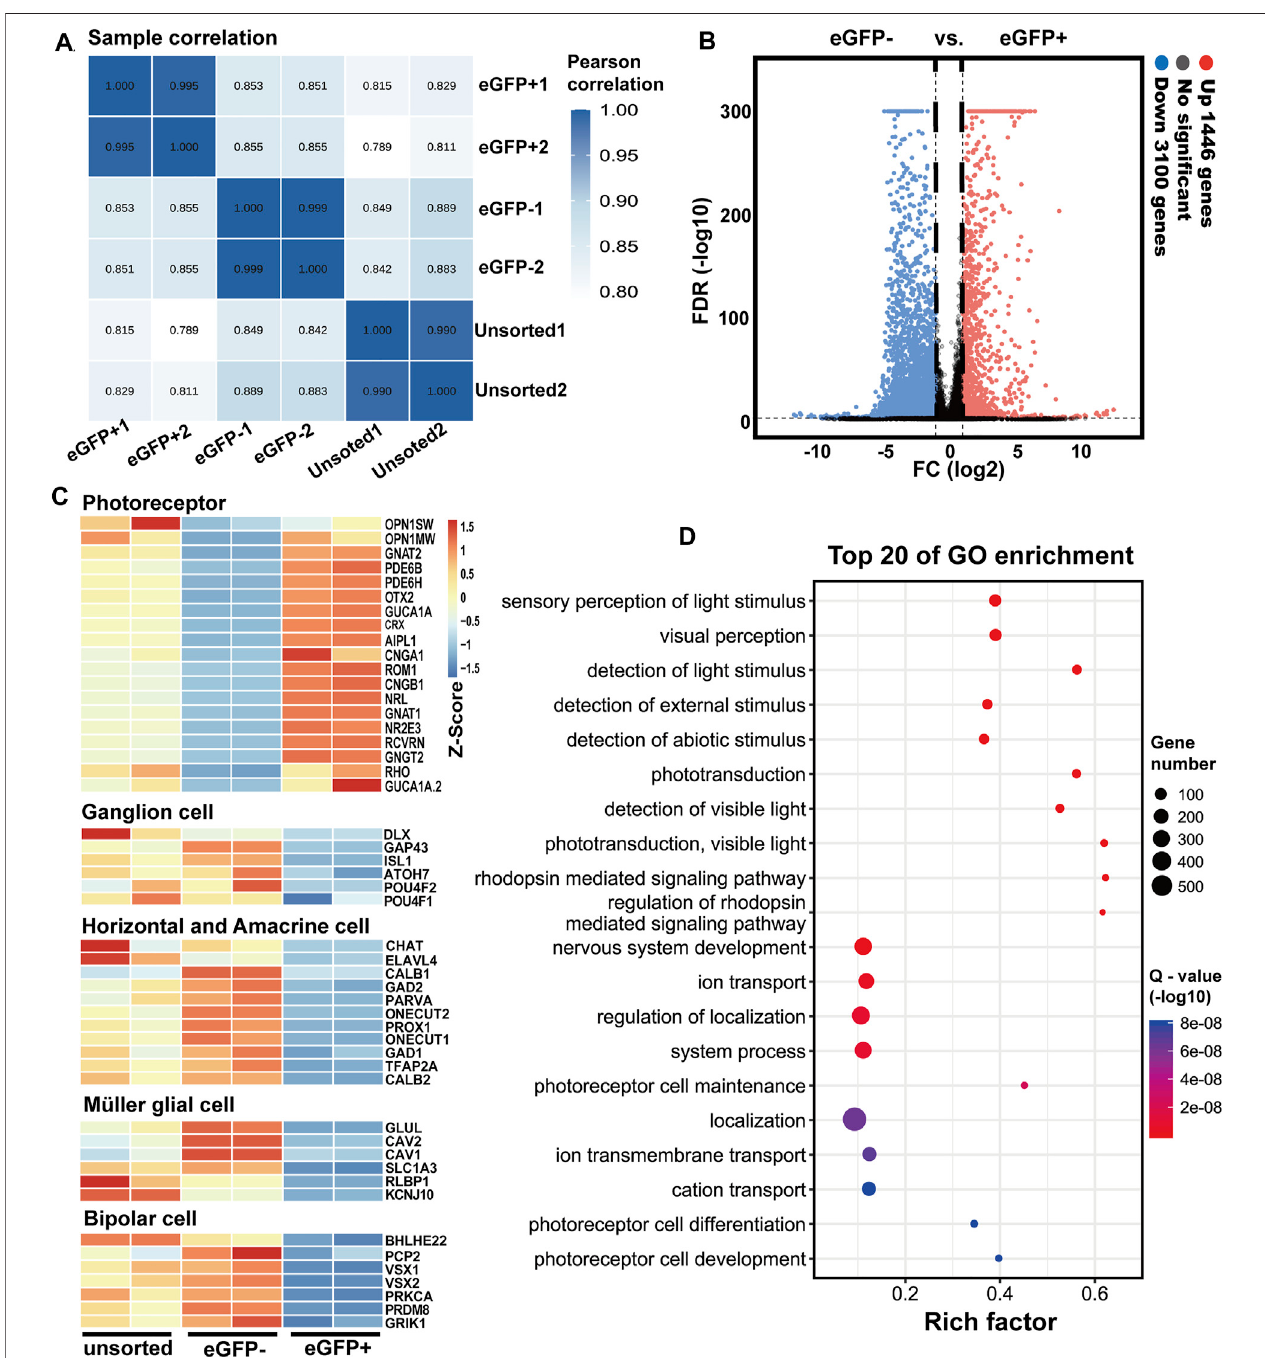
FIGURE 5 | Transcriptome analysis of RCVRN-eGFP positive cells isolated from D150 retinal organoids by fl uorescence-activated cell sorting. (A) Sample correlation of replicates of the unsorted, eGFP- and eGFP+ cells. (B) Volcano plots indicated fold change (FC) in gene expression between eGFP- and eGFP+ cells. Up, upregulated;Down,downregulated;vs.,versus;FDR,falsediscoveryrate. (C) Heatmapsshowgeneexpressionpatternsofknownretinalcell-type-speci fi cgenesinthe unsorted, eGFP- and eGFP+ cells. Blue to orange represented a gradient from low to high gene expression. (D) Bubble chart shows the top 20 enriched Gene Ontology (GO)-terms of biological processes in eGFP+ cells based on differentially expressed genes (DEGs) between eGFP- and eGFP+ cells. Rich factor (number of DEGsenrichedinGO-terms/numberofallgenesinthebackgroundgeneset).Colorandsizeofthebubblerepresentedenrichmentsigni fi canceandthenumberofDEGs enriched in GO-terms, respectively. Q-value < 0.05 was de fi ned as signi fi cantly enriched.